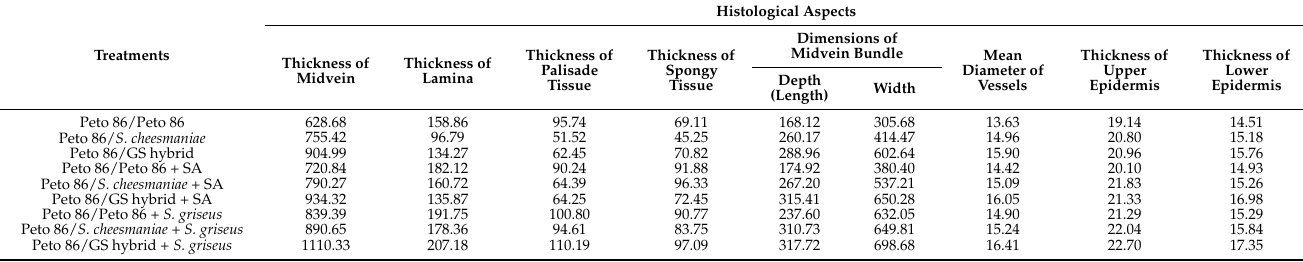
Table 5. Counts and measurements in micrometres ( µ m) of certain histological characteristics in transverse sections through the blade of the terminal leaflet of the fourth compound leaf developed on the main stem of tomato plants, aged 60 days, affected by grafting, rootstock seed treatments with shikimic acid (SA), and colonisation with Streptomyces griseus (SG) (means of three sections from three